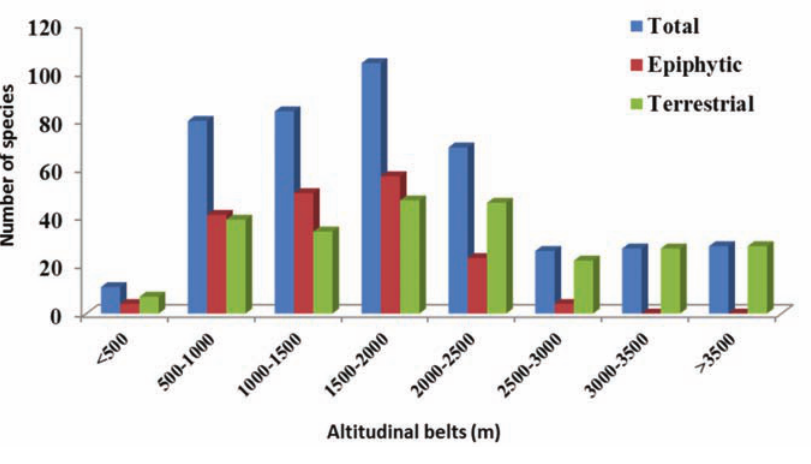
Figure 3. Distribution of orchids in different altitudinal